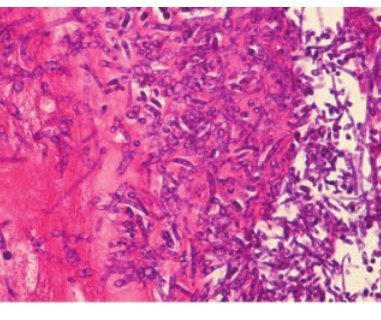
Figure 2. Hematoxylin and eosin stain of resected tissue (magnification